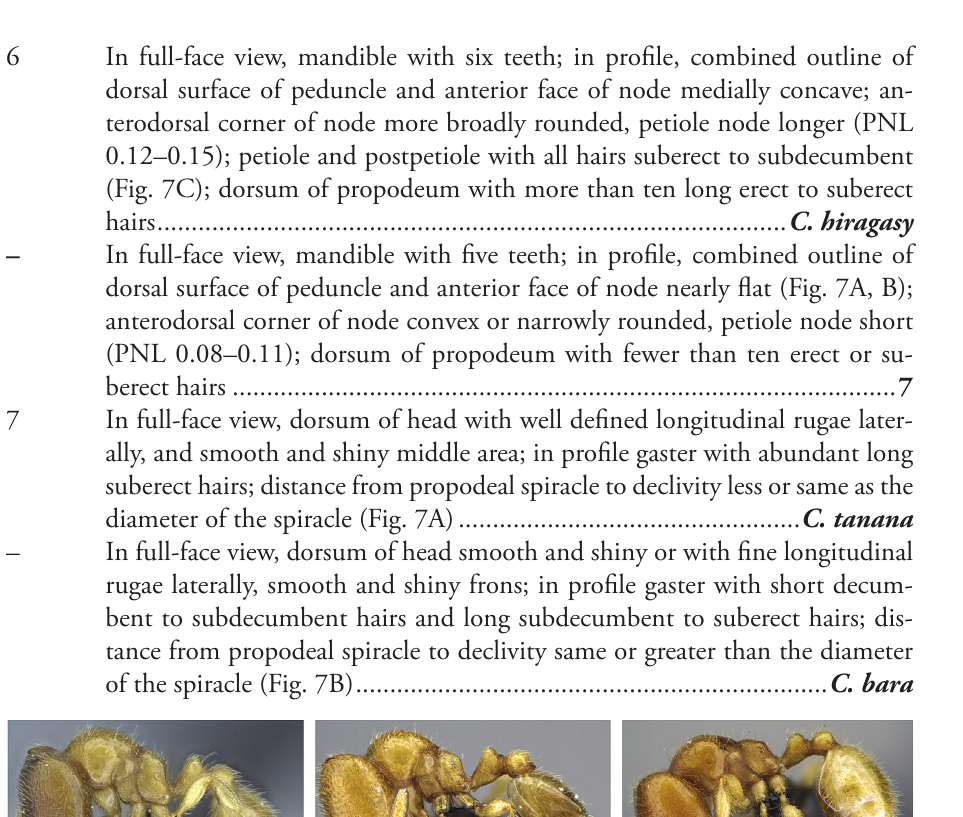
Figure 7. Petiole and postpetiole in profile view of A Carebara tanana (CASENT0211708) B Carebara bara (CASENT0483010) C Carebara hiragasy (CASENT0496886) 8 In full-face view, lateral margins of head straight or weakly convex, when weakly convex posterolateral corners nearly rounded (Fig. 8A, B, C, D) ..... 9 – In full-face view, lateral margins of head convex or nearly straight, when near- ly straight or weakly convex posterolateral corners of head more prominent and narrowing posteriorly (Fig. 8E, F, G H), when lateral margins are convex like (Fig. 8E) then posterolateral corners rounded ..................................... 16 9 Dorsal surface of head not completely sculptured, frons smooth and shiny, dorsolateral face of head with longitudinal rugae, mandible with five or six teeth (Fig. 9A, B) ...................................................................................... 10 – Dorsal surface of head sculptured, when median area of head not completely sculptured or smooth and shiny, head with longitudinal and irregular ru- gae and reticulate-rugose near the posterior margin, mandible with five teeth (Fig. 9C, D) ..............................................................................................